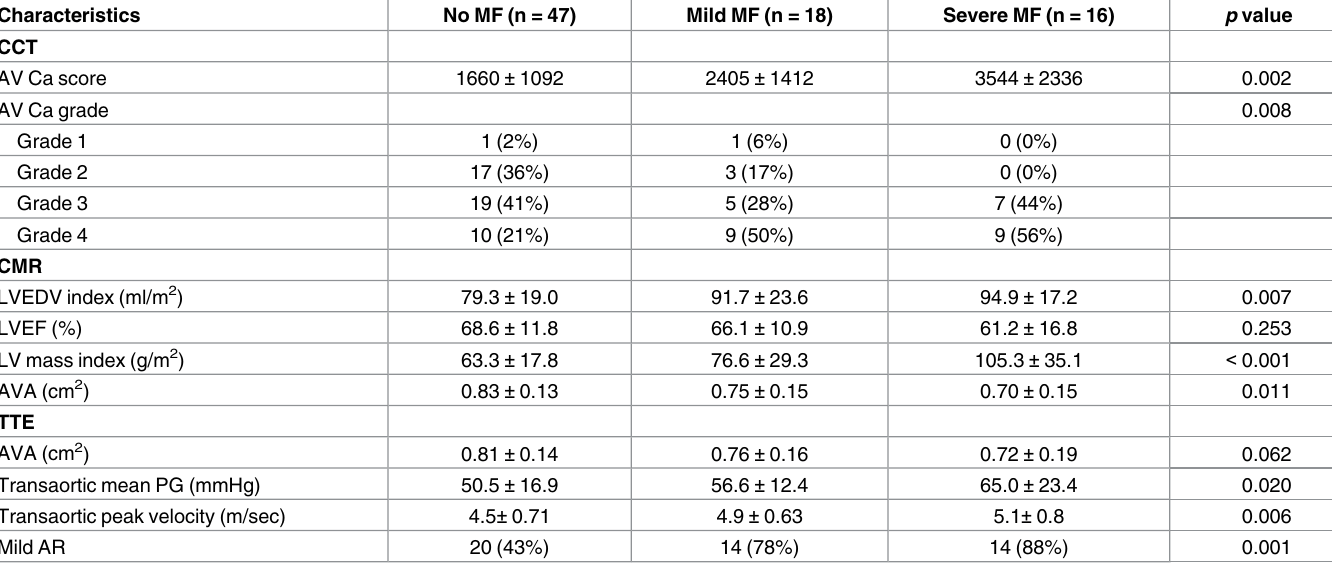
Table 2. Differencesof multimodality imaging findings according to the severity of MF.